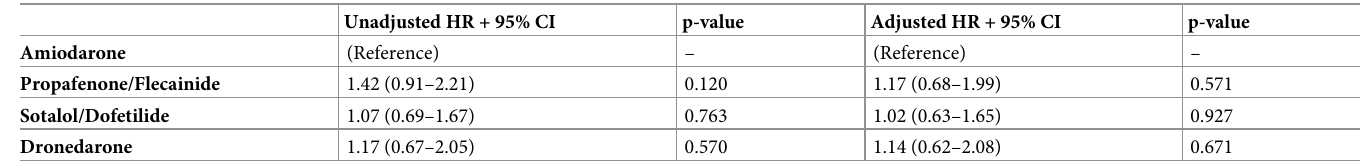
Table 4. Unadjusted and adjusted Cox proportional hazard ratios for: Discontinuation of AAD before 90 days after ablation (Amiodarone is reference group).